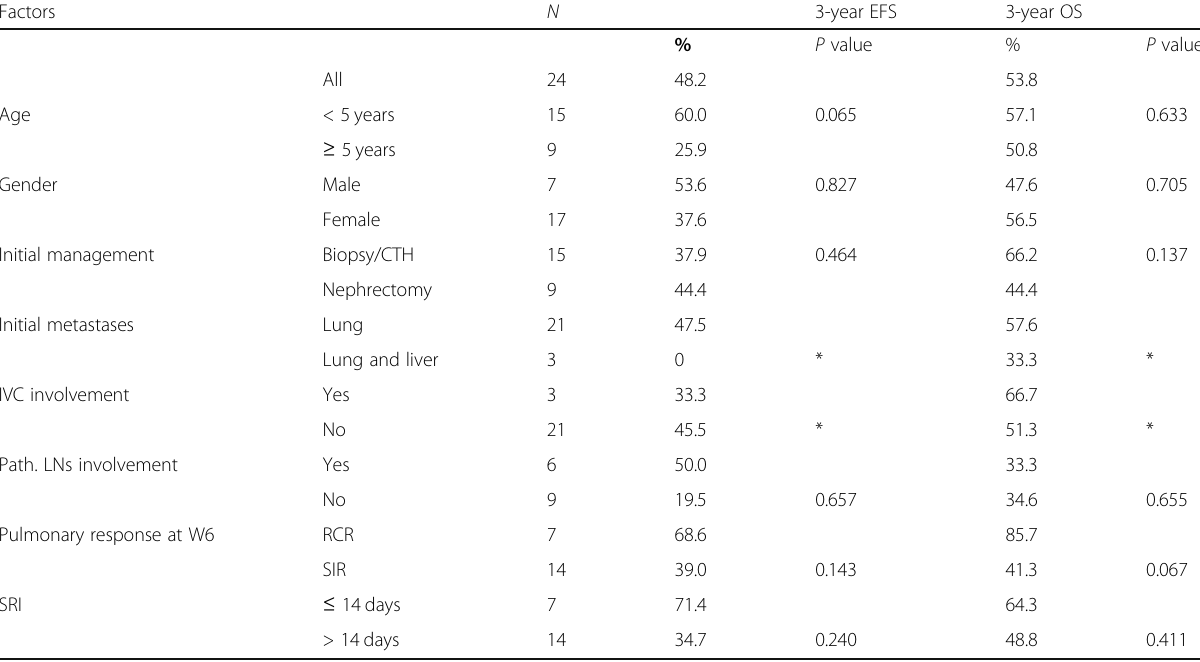
Table 3 Survival outcome of study patients in correlation to their demographic and clinical characteristics